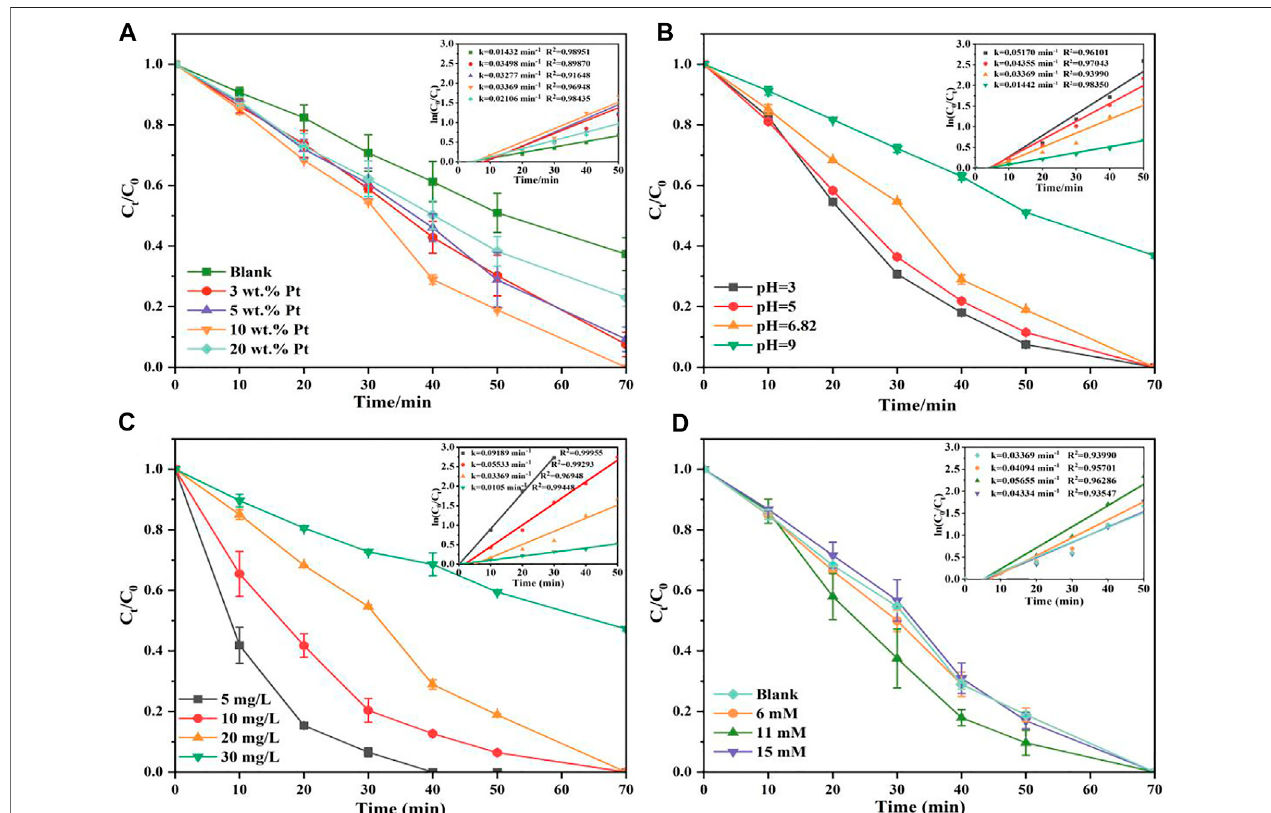
FIGURE 5 | Change Pt load on TNT-400 (A), effects of pH ini (B) on RhB photodegradation by TNT-400-Pt (10), the effect of initial concentration of RhB on the photocatalytic degradation of TNT-400-Pt (10) (C) , effects of H 2 O 2 (D) on RhB photodegradation by TNT-400-Pt.